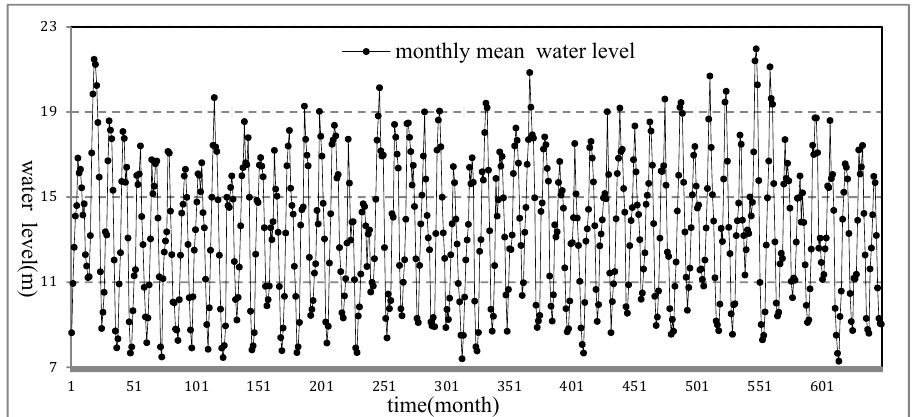
Figure 8. Monthly mean water level at the Xingzi Station.